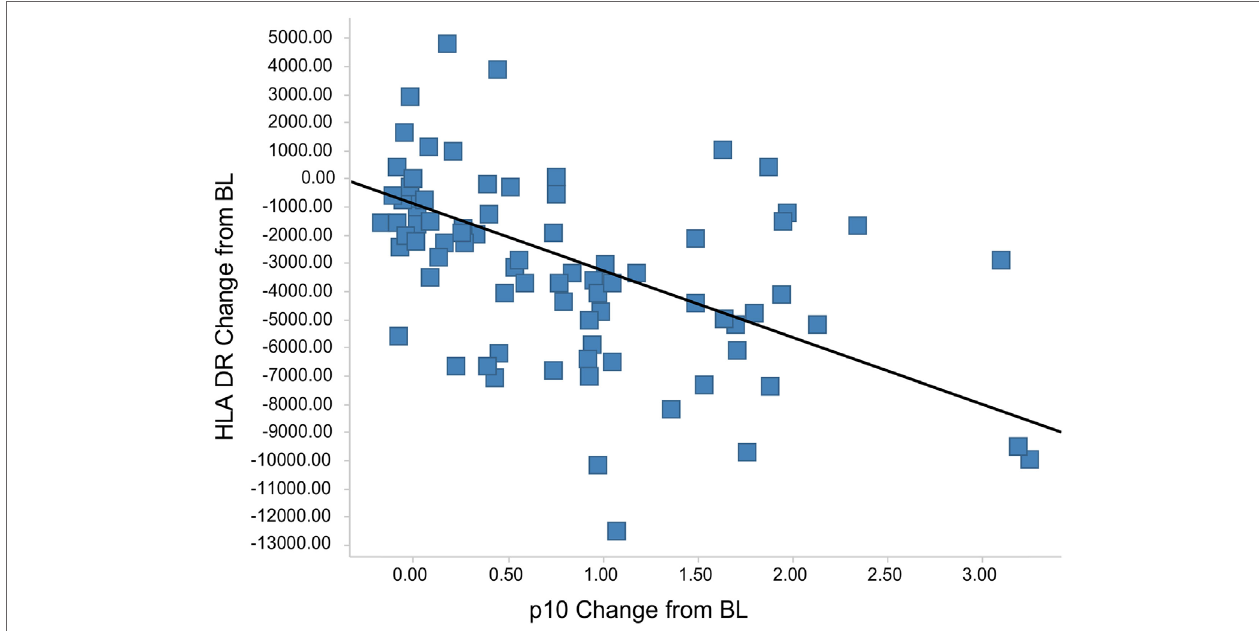
FIgURe 7 | Lip10 accumulation correlates with decrease in major histocompatibility complex class II (MHCII) surface expression in clinical study participants. A linear regression analysis was performed with Lip10 accumulation and MHCII expression, both calculated as change from baseline, before dosing at time- point = 0 h. The analysis was restricted to time-points before dosing and 8 and 12 h after dosing to restrict the analysis to time-points with large enough overlap in the kinetics of both markers ( r 2 = 0.35, p < 0.001 × 10 − 9